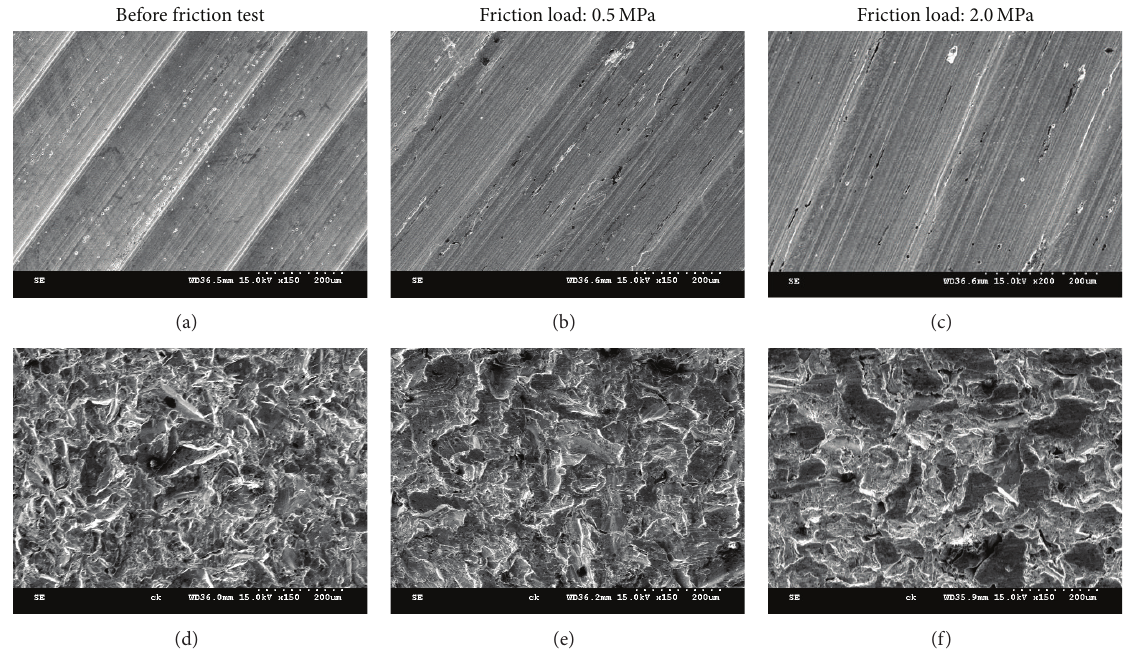
Figure 6: SEM images of test specimens (a)–(c) MM1, (d)–(f) AJM1, at friction distance 100 m.